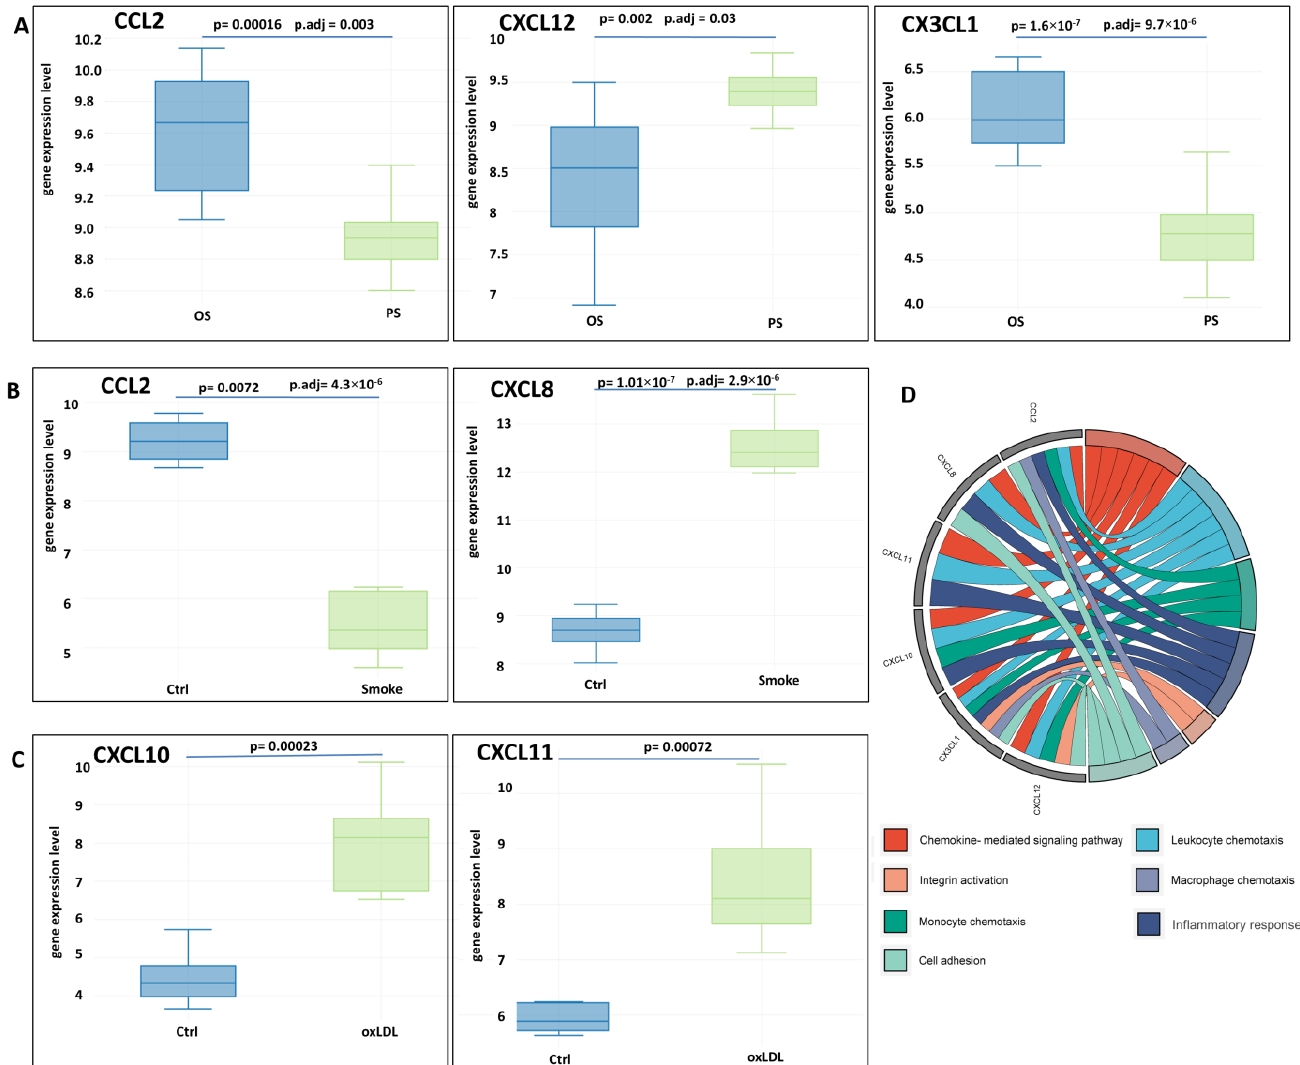
Figure 14. Patterns of chemokine gene expression in endothelial cells in the comparison groups (( A ) GSE103672; ( B ) GSE141136; ( C ) GSE29881) associated with exposure to risk factors. ( D ) Gene ontology analysis by biological process for differentially expressed chemokine genes in datasets. Note: the data are visualized as box plots ( A – C ). Statistically significant differences ( p values and p values corrected with the Benjamini and Hochberg (adj.P.Val) algorithm) are shown between comparison groups.